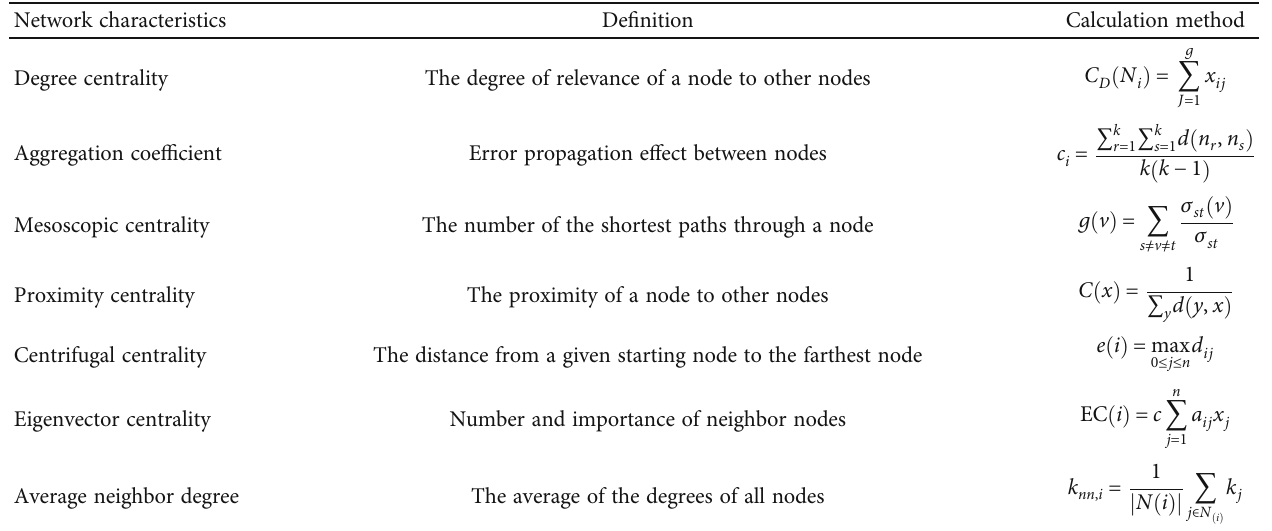
Table 1: Network characteristics and calculation methods of complex networks.